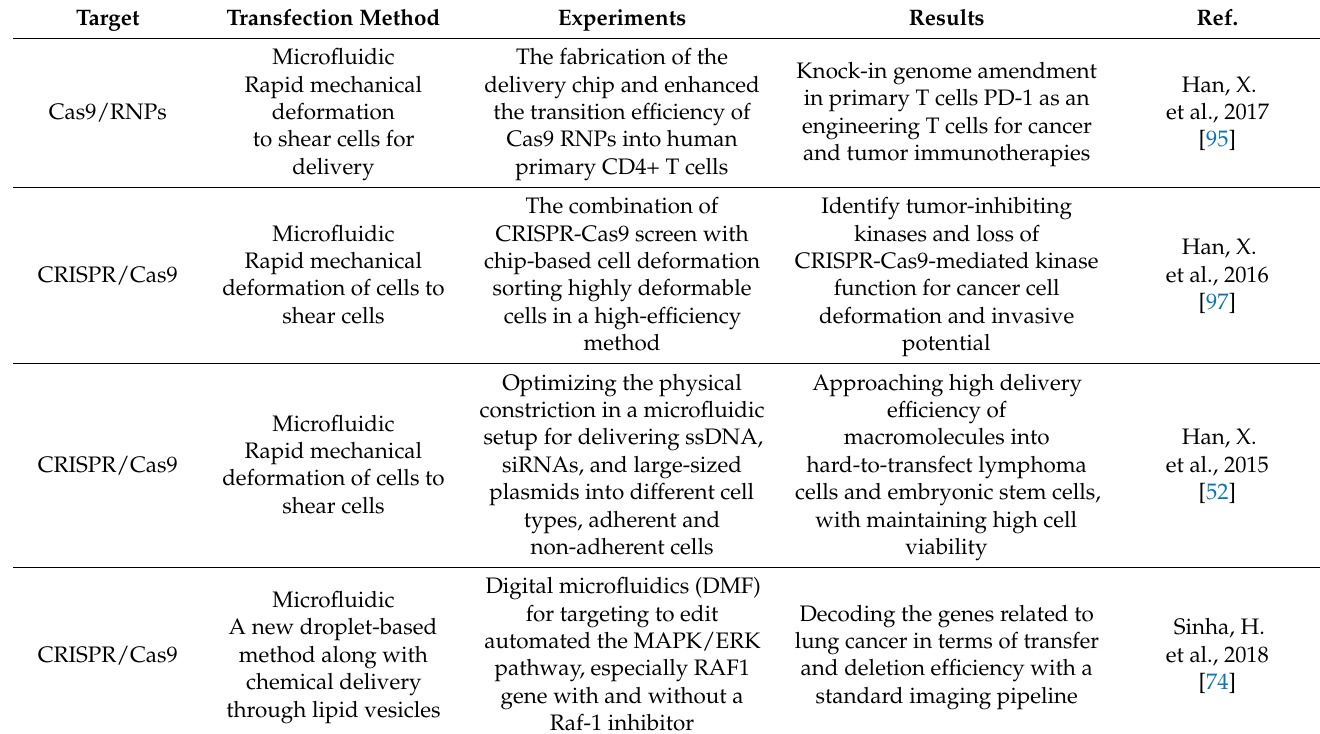
Table 1. The clinical application of employing microfluidic methods for gene delivery. Target Transfection Method Experiments Results